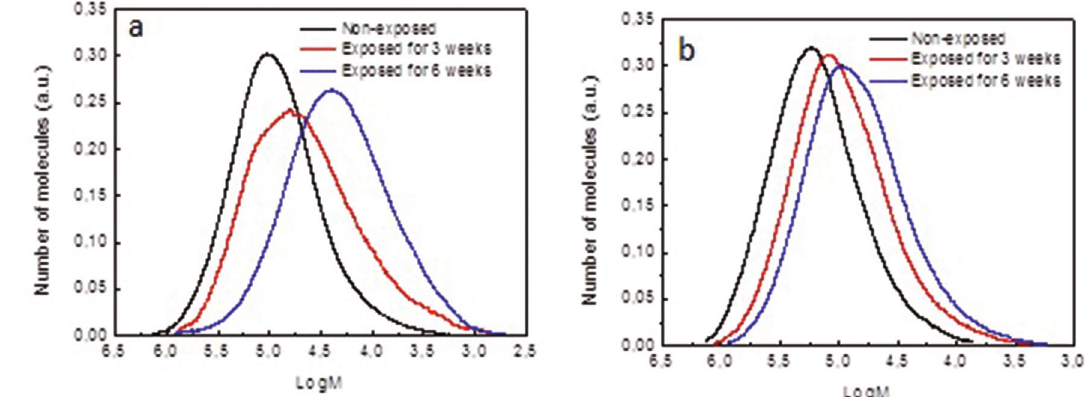
(a) and PHB (b) not exposure and exposed for different 1 ABS